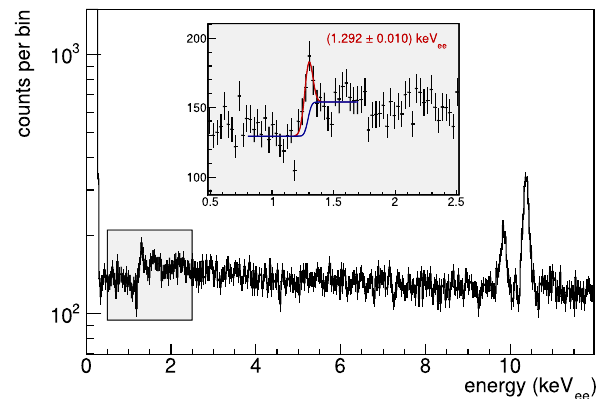
Fig. 4 CalibratedbackgroundspectrumcollectedintheHPGedetector after beam irradiation: lines from activation are visible at 1.30, 9.87 and 10.37keV ee . The 1.30keV ee line (red, in the inset) is used to validate the energy scale at low energy. The line position was tested with several background descriptions (blue), fit ranges and